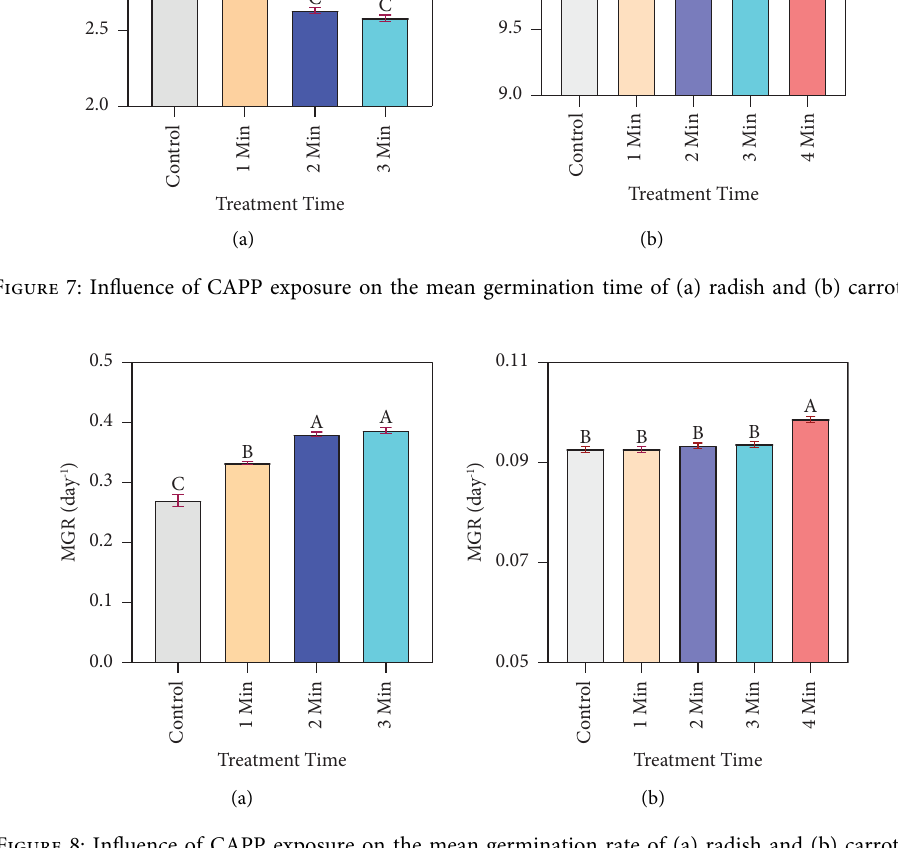
Figure 8: Infuence of CAPP exposure on the mean germination rate of (a) radish and (b) carrot.